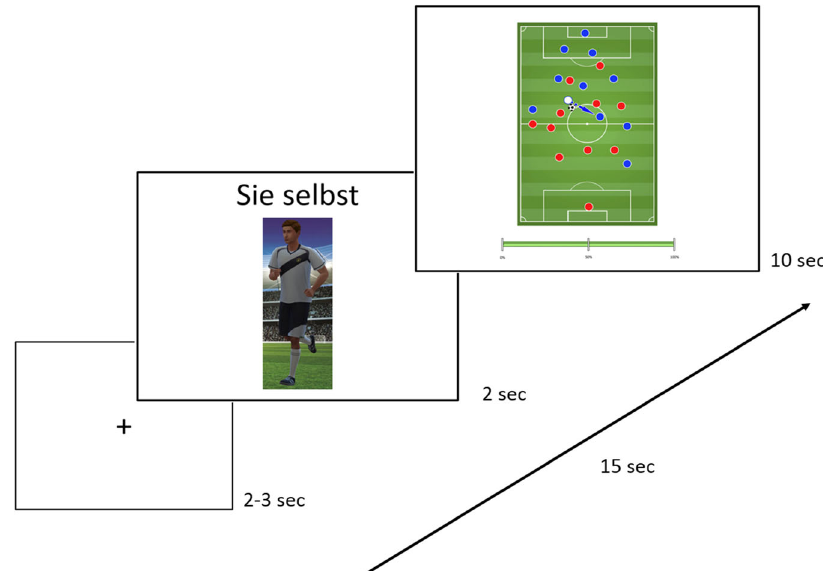
Fig. 1 Schematic representation of an experimental trial. “ Sie selbst ” indicates that the likelihood needs to be speci fi ed for the